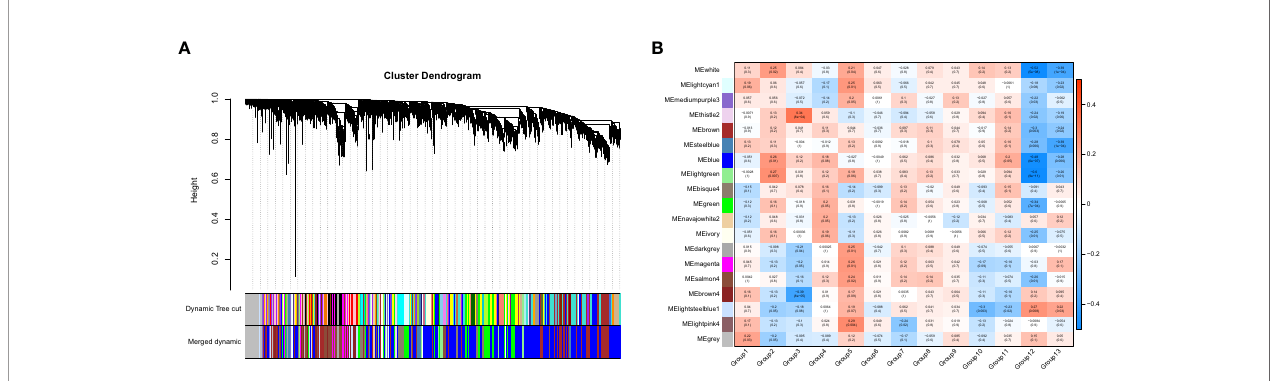
FIGURE 7 | The gene set enrichment analysis and module identi fi cation. (A) Dendrogram of all fi ltered gene sets enriched according to a dissimilarity measure (1- TOM) and the cluster module colors. The fi rst set of modules was obtained with the Dynamic Tree Cut algorithm and the correlated modules were merged together. Each branch in the fi gure represents one gene and every color below represents one co-expression module. (B) Heatmap of the correlation between the pharmaceutical effect of TCM fractions and MEs in breast cancer. The darker the color of the module, the more signi fi cant the relationship.